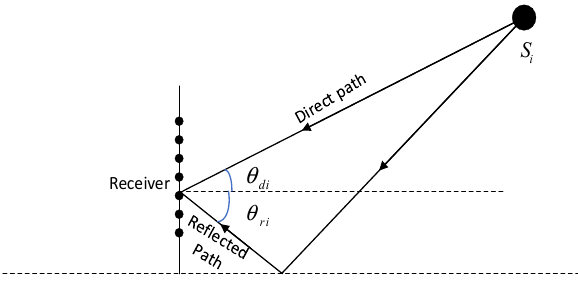
Figure 1. Signal reception model in low-altitude multipath environment.